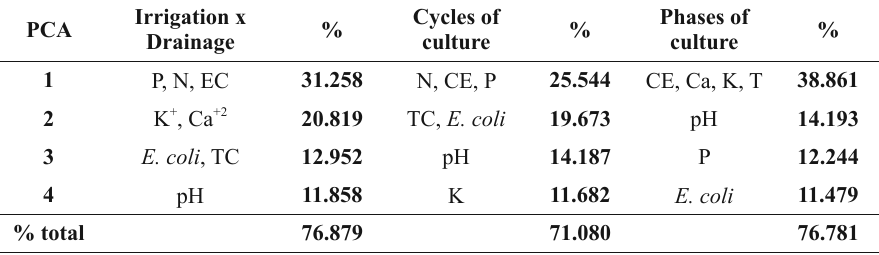
Partial and total variance explained by principal component analysis in Camaquã/RS/ Brazil. The variable has a correlation > 0.75 with the PCA.